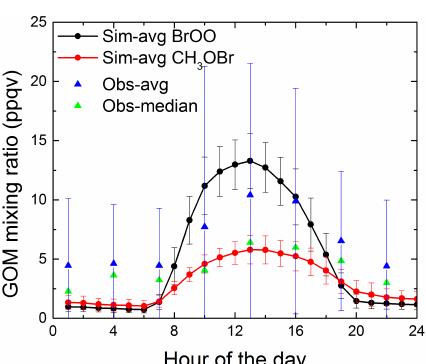
Figure 7. Simulated diurnal cycles of Br (red) and BrO (blue) of the base case. Figure 8. Simulated average diurnal cycles of GOM for the base